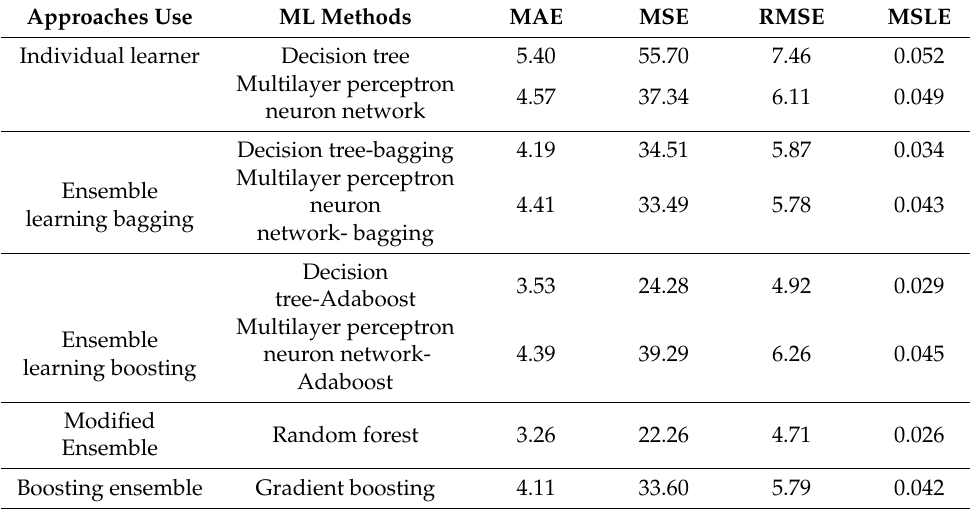
Table 13. Statistical